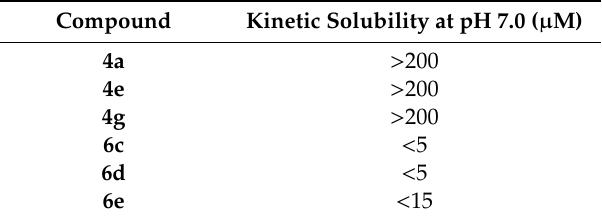
Table 2. Aqueous kinetic solubility of selected